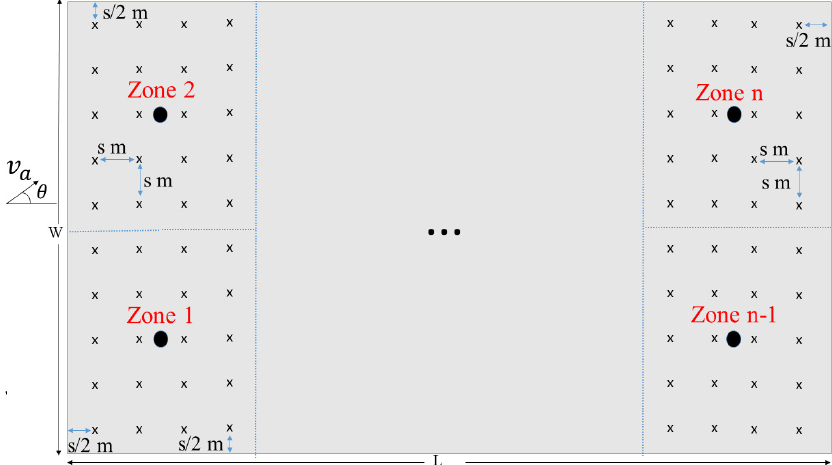
Figure 1. Two dimensional domain for a generic rectangular prism type fruit orchard. Here, “x” denotes trees, “ (cid:8) ” hot air blowers, v a the wind speed, and θ wind